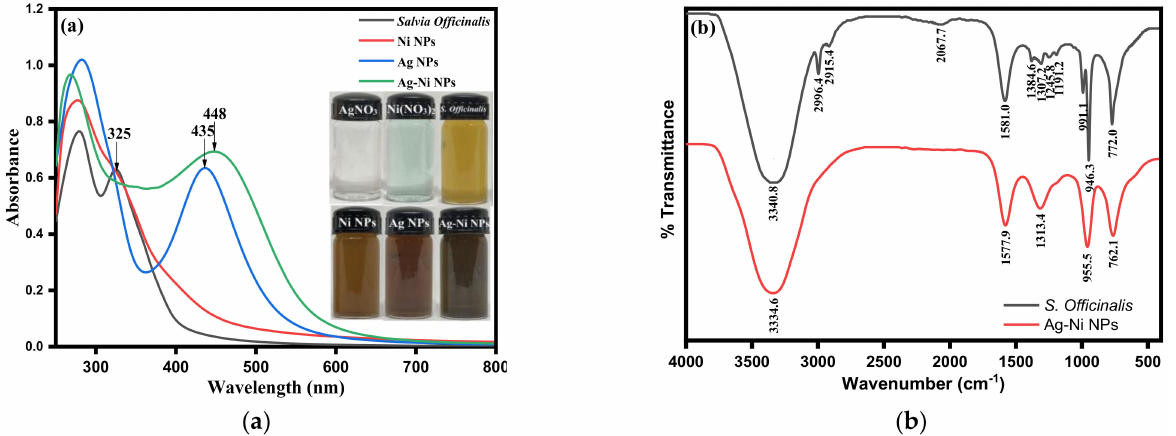
Figure 2. ( a ) UV–vis spectra of Salvia officinalis Ag NPs, Ni NPs and Ag-Ni NPs at 30 ◦ C (inset optical images), and ( b ) Fourier transform infrared (FTIR) spectra of Salvia officinalis extract and Ag-Ni